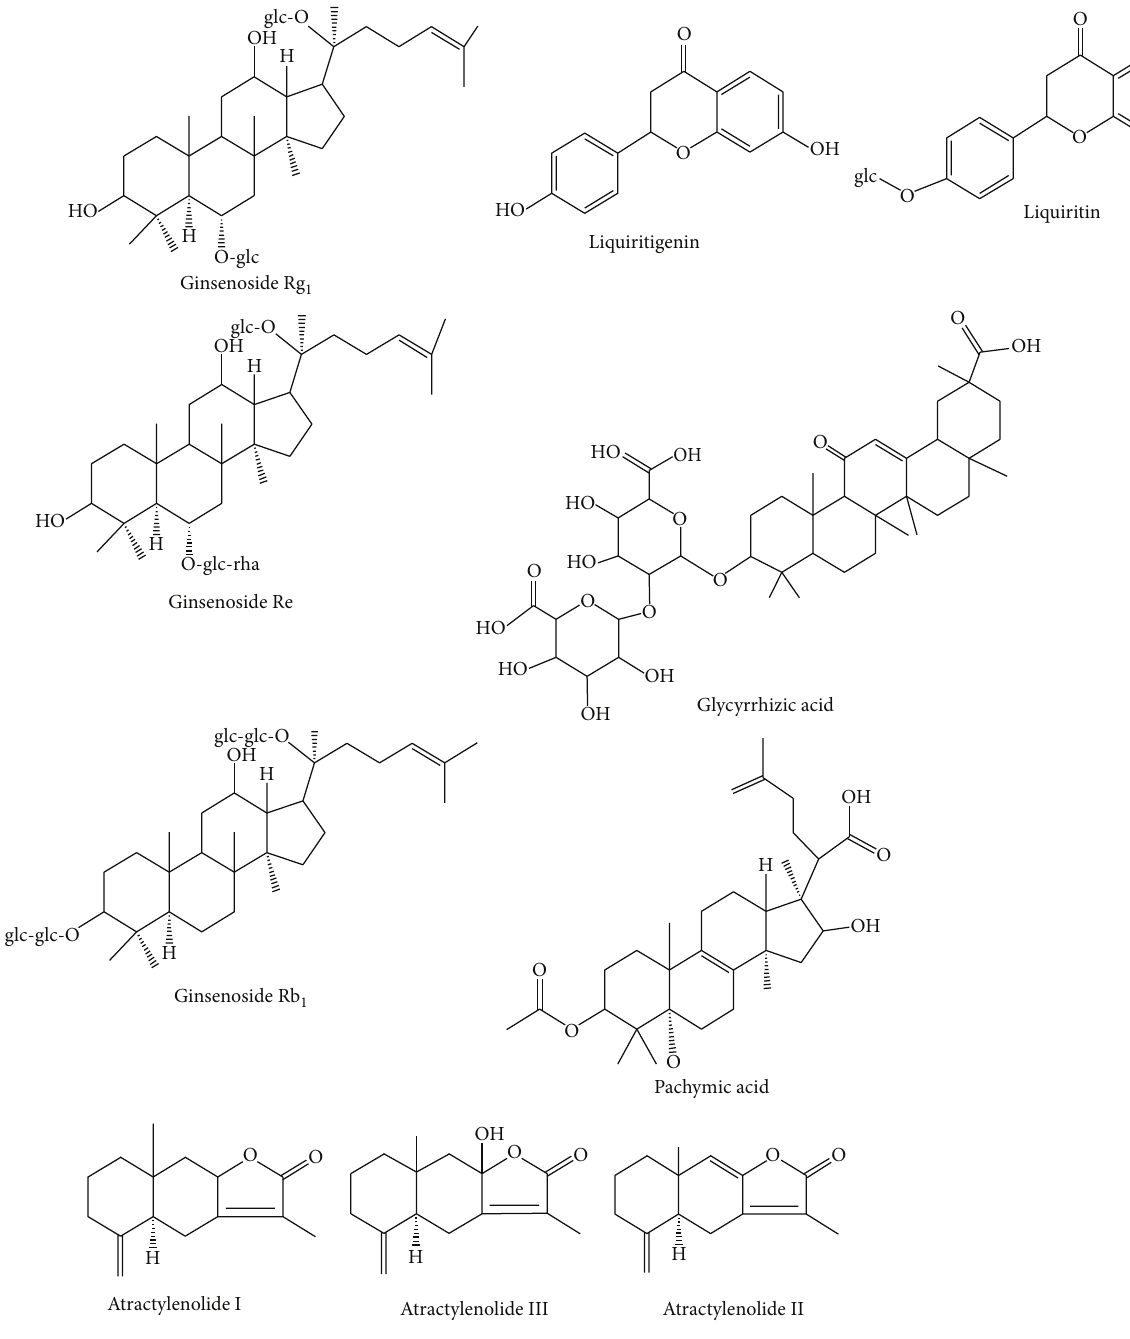
Figure 1: The chemical structure of ginsenoside Rg 1 , Re, Rb 1 , liquiritin, liquiritigenin, glycyrrhizic acid, atractylenolide I, atractylenolide II, atractylenolide III, and pachymic